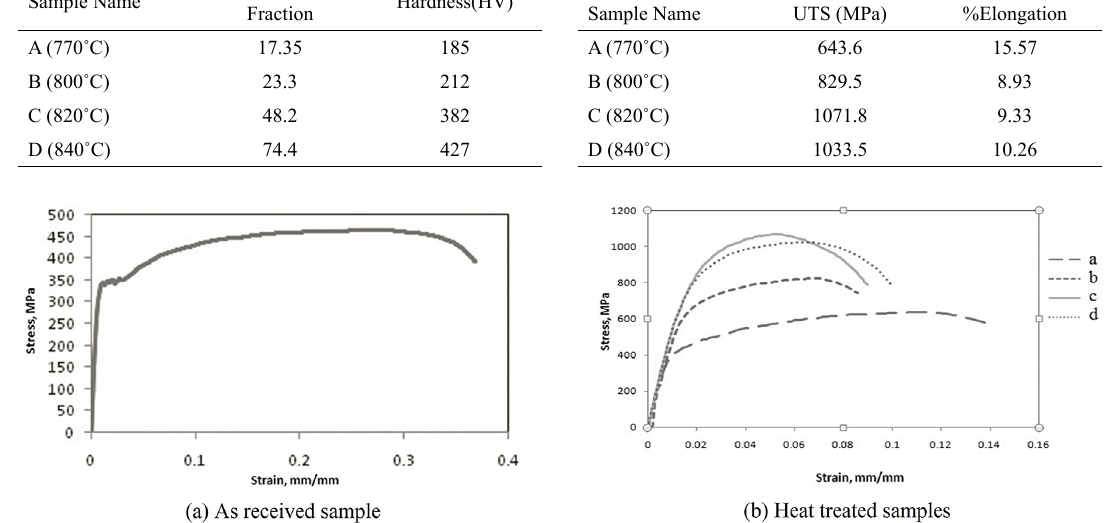
Figure 5. Engineering stress-strain curves of (a) as-received and (b) heat-treated samples (a) A, (b) B, (c) C, (d) D.